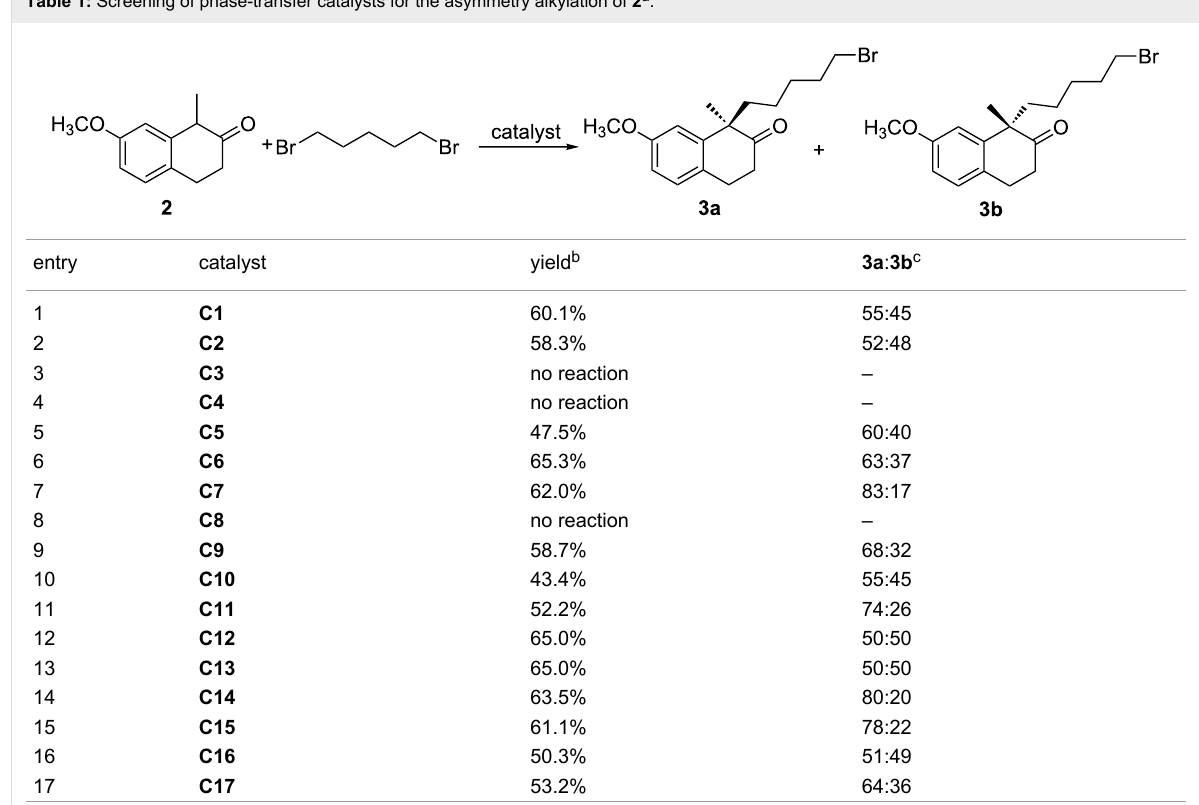
Table 1: Screening of phase-transfer catalysts for the asymmetry alkylation of 2 a